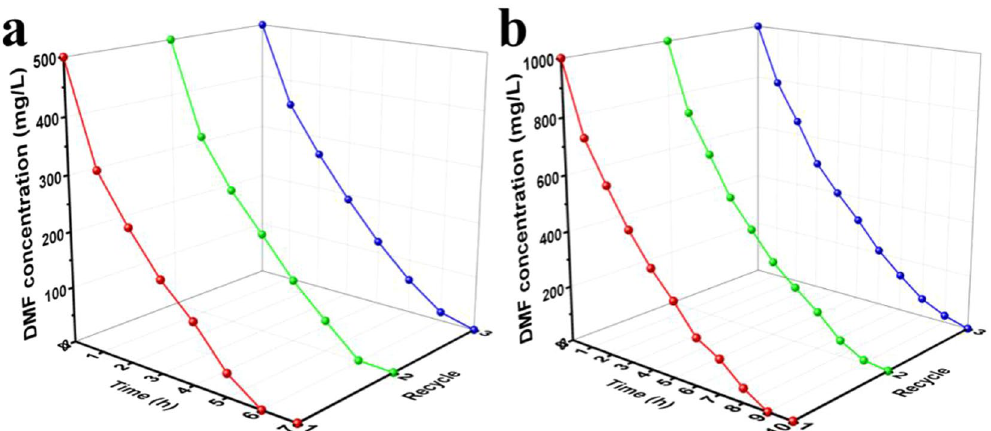
Figure 9. The biodegradation process of P . denitrificans packed inside cage and cycling performance (initial concentration of DMF = 500 mg/L ( a ), 1000 mg/L ( b ), the weight of P . denitrificans = 2.0 g, DMF solution volume = 50 mL, T = 30